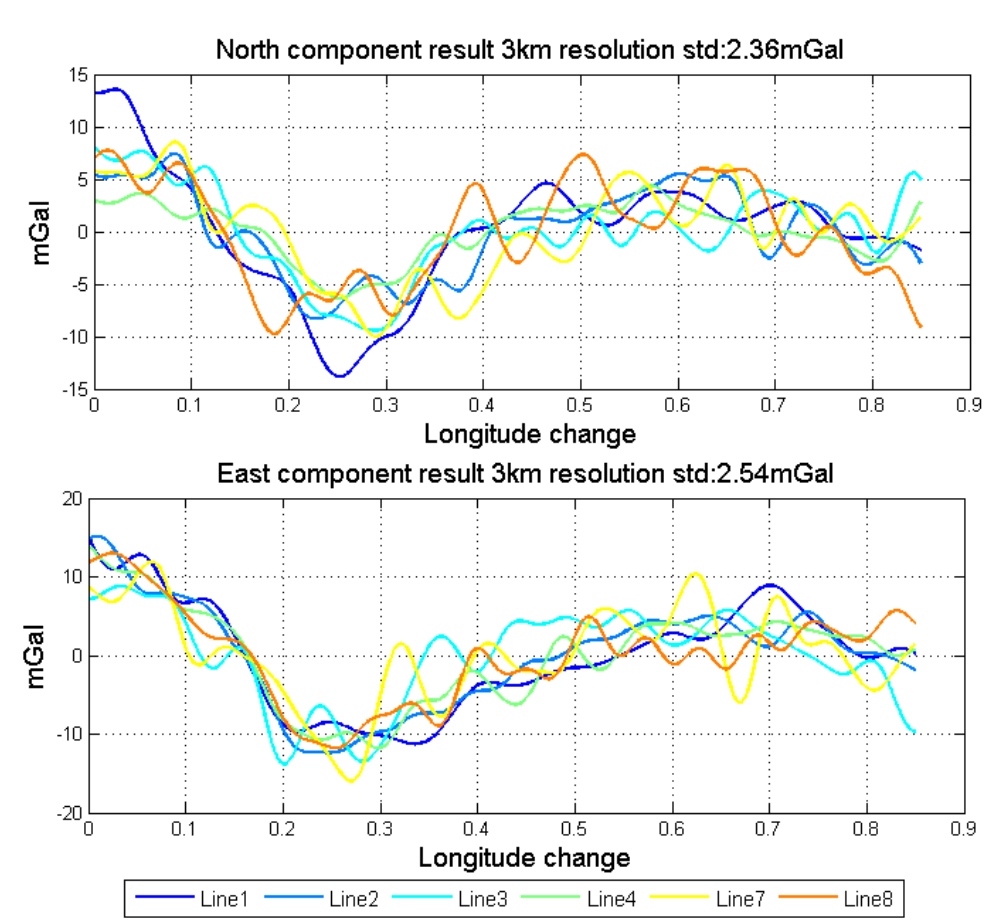
Figure 21. Horizontal components fusion result in 3 km